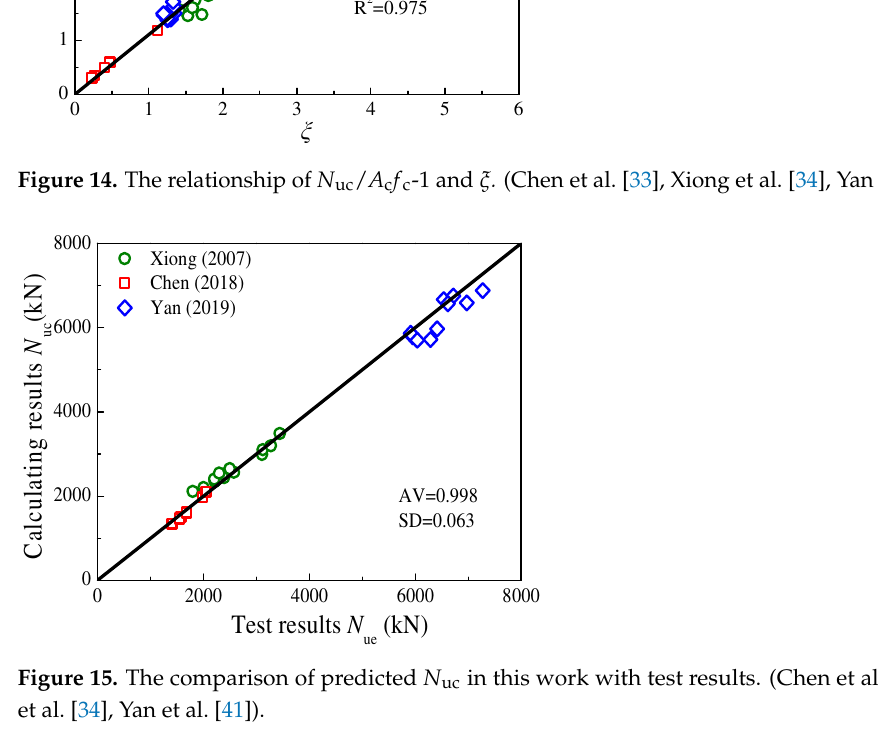
Table 5. The database of rectangular UHPCFST members subjected to pure bending.